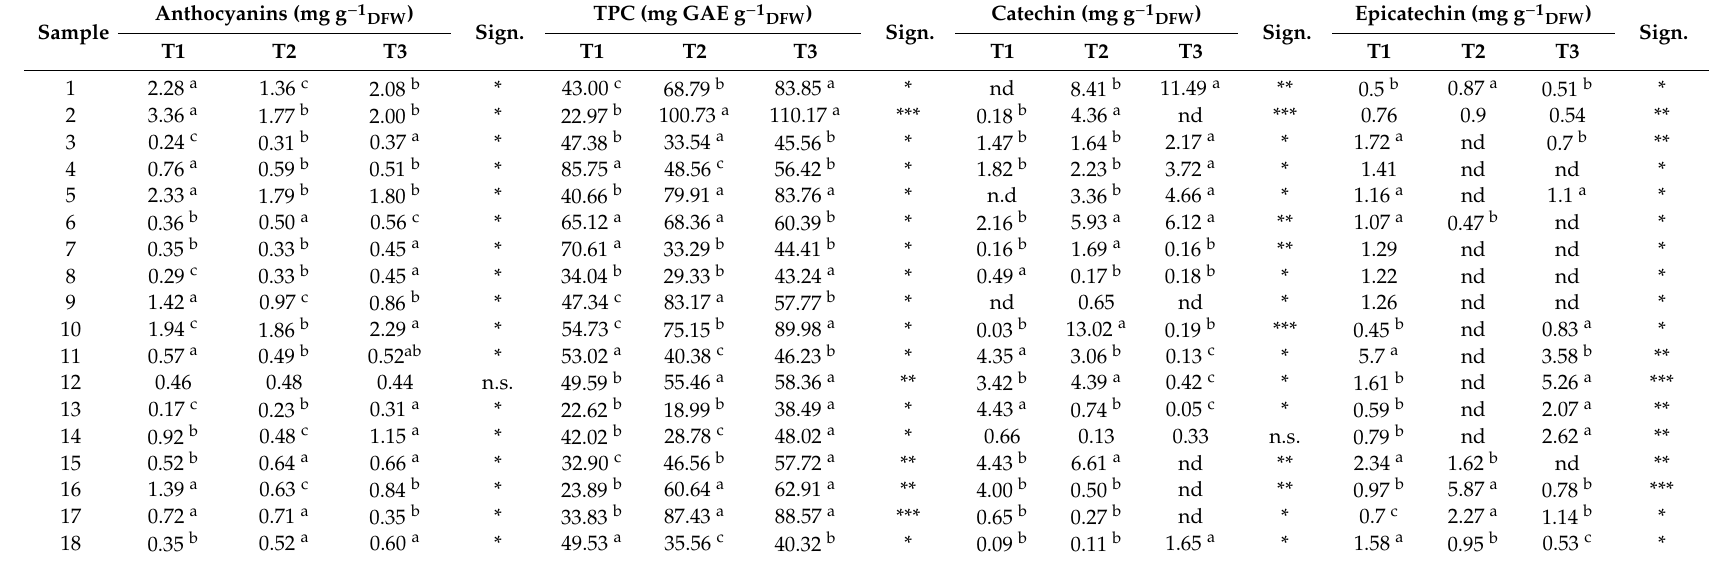
Table 4. Anthocyanins, total polyphenols (TPC) and flavanols content of the Criollo cocoa samples after fermentation and drying (T1) and after roasting (T2, 120 ◦ C for 22 min; T3, 135 ◦ C for 15 min). The data are expressed as mean of triplicate analysis.